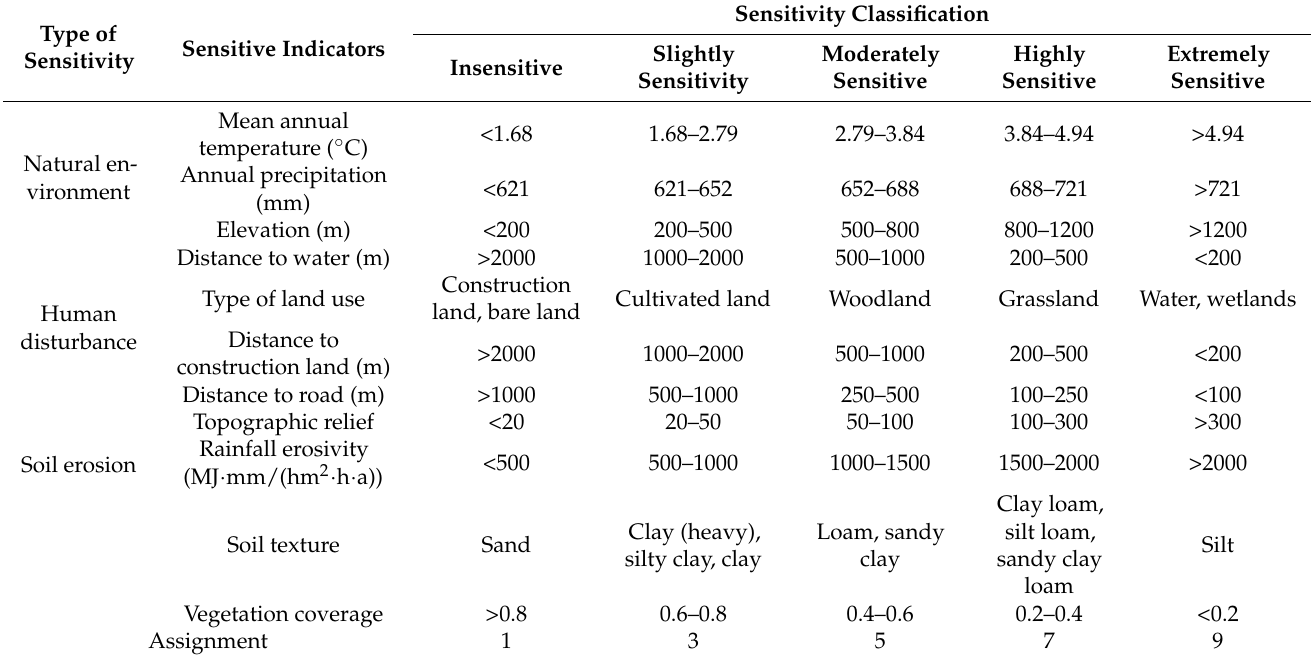
Table 2. Evaluation indicators and classification of ecological